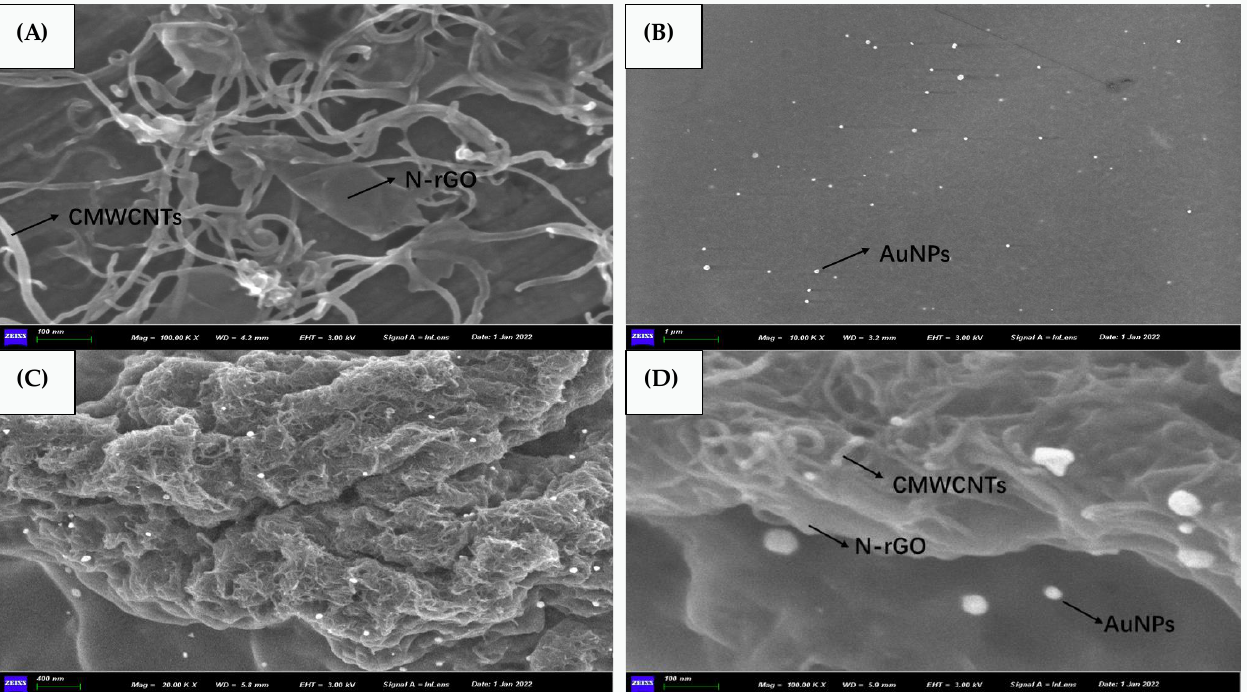
Figure 2. ( A ) SEM image of N-rGO@CMWCNTs; ( B ) SEM image of CS@AuNPs; and ( C , D ) SEM images of